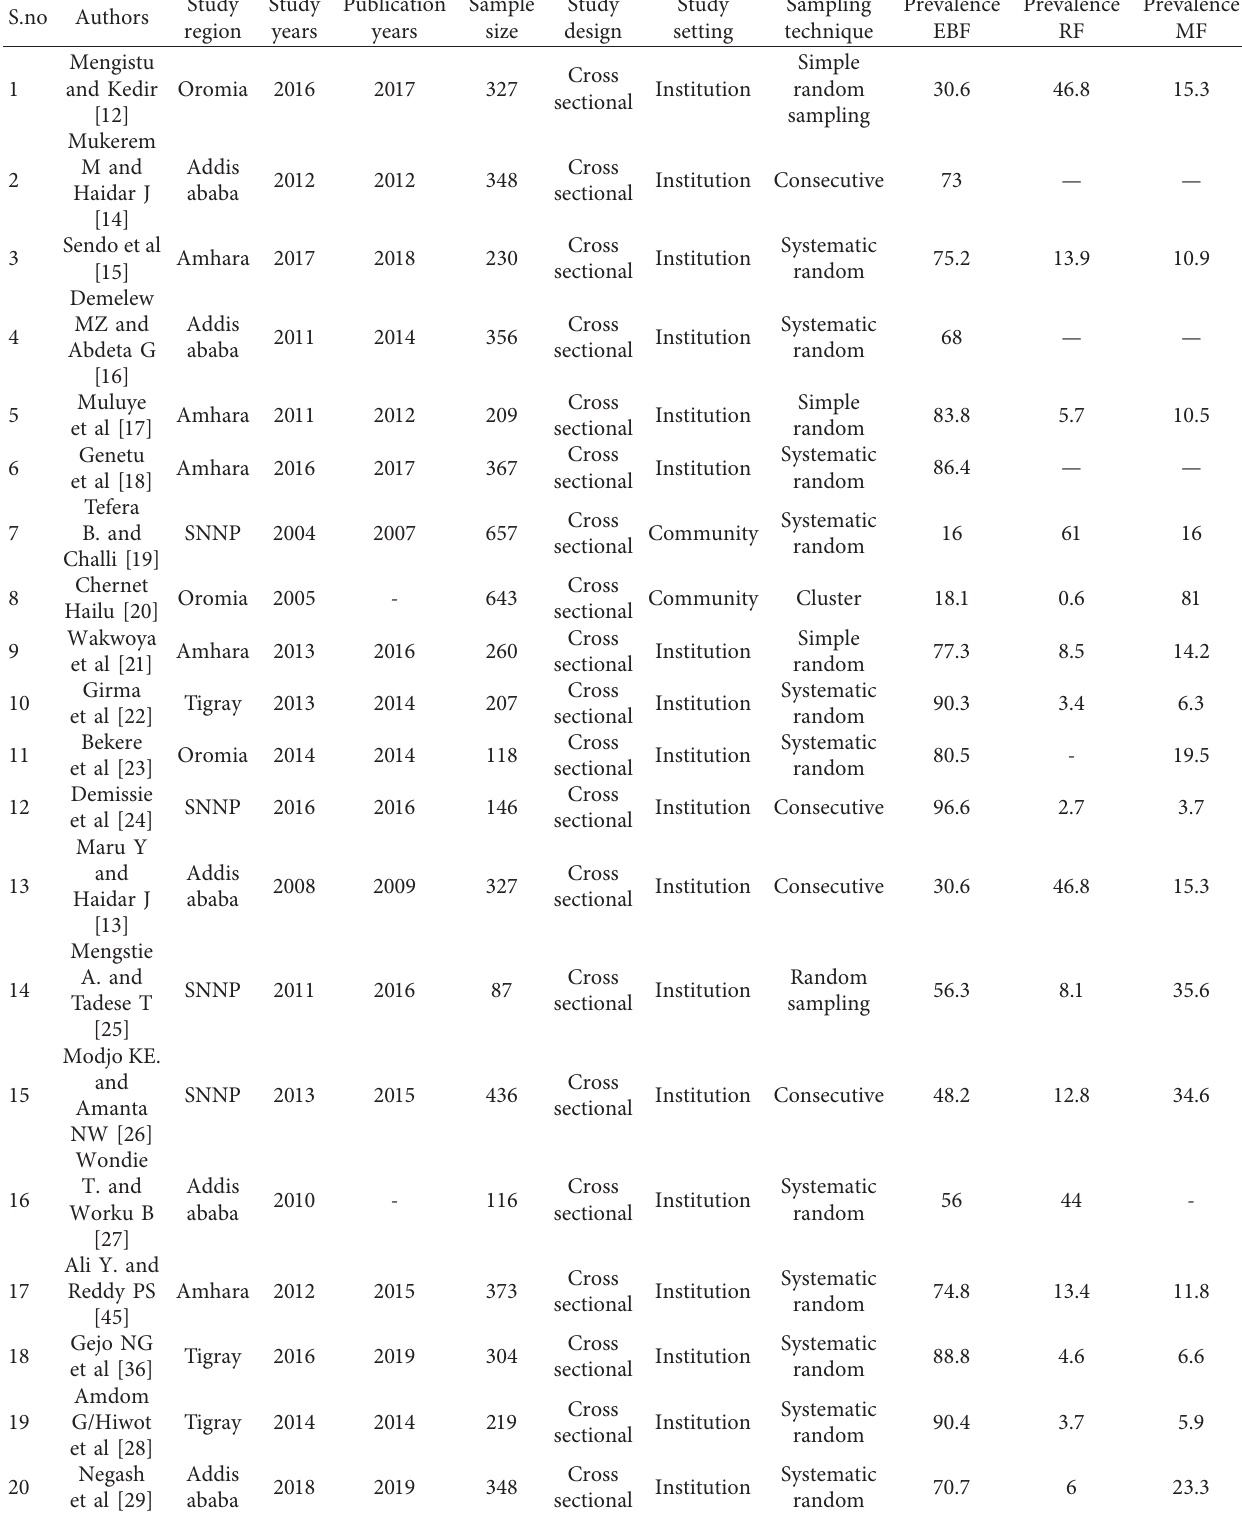
Table 1: . Characteristics of 26 included studies to estimate the pooled prevalence of exclusive breastfeeding and 24 studies for replacement feeding and mixed feeding practices of HIV-exposed infants in